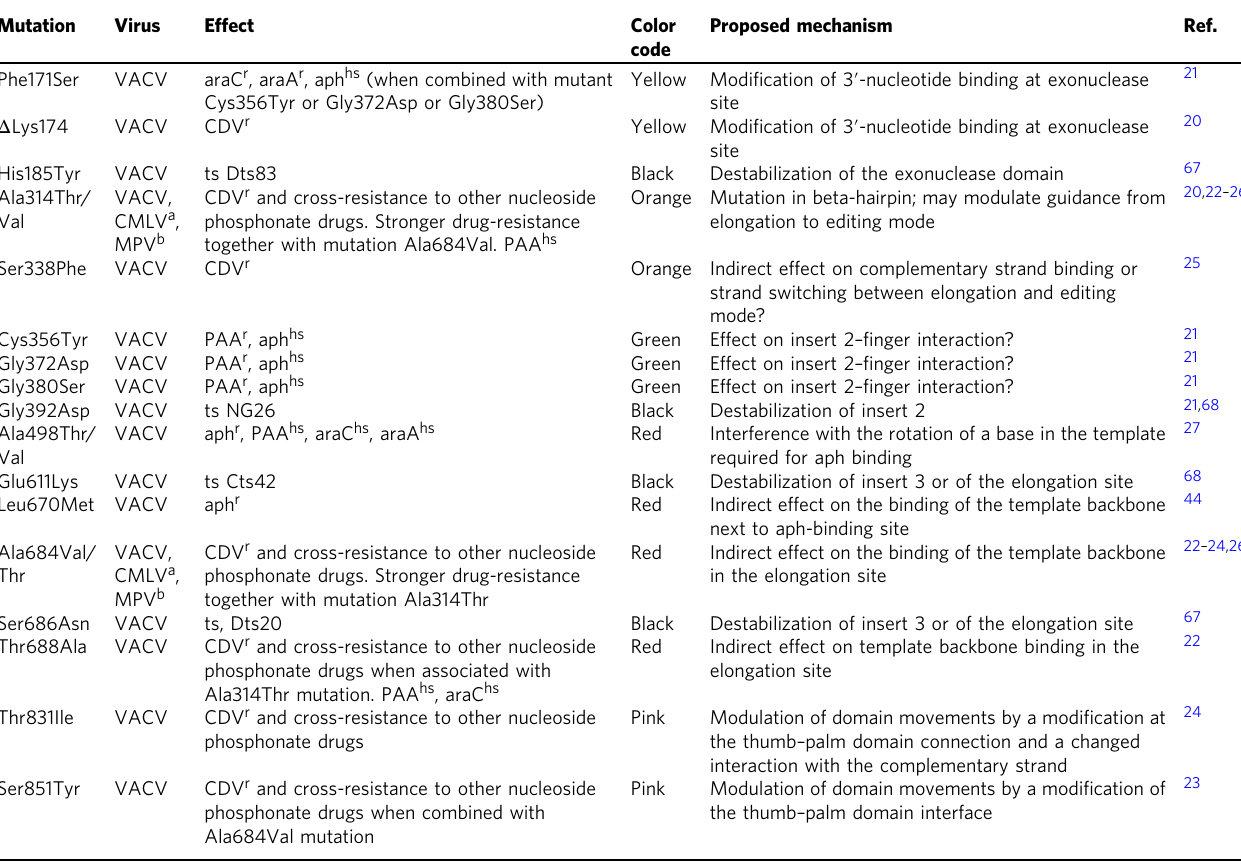
Table 2 E9 drug-resistant and temperature-sensitive mutants